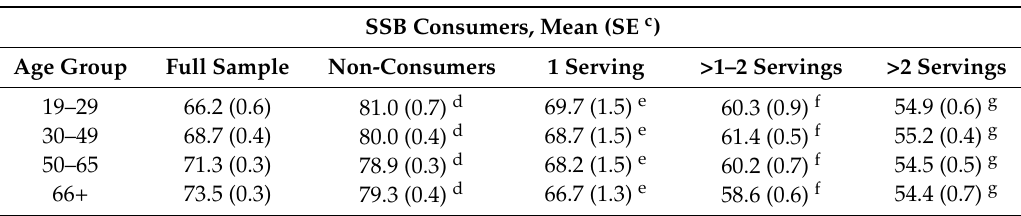
Table 4. Distribution of HBI a score among the full sample and across levels of SSB b consumption, NHANES adults (aged 19+)